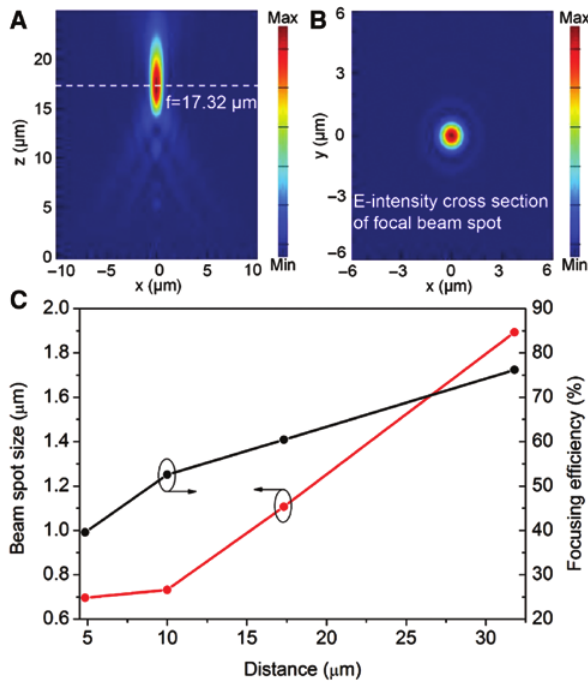
Figure 2: Simulation results of metalens. Simulated E-intensity profile in (A) the propagation plane and (B) the focal plane of a 20- μ m-diameter metalens with a focal length of 17.32 μ m (NA = 0.5). (C) Simulated focal spot size and the focusing efficiency with respect to different focal lengths. The arrows indicate the corresponding y -axis of the data